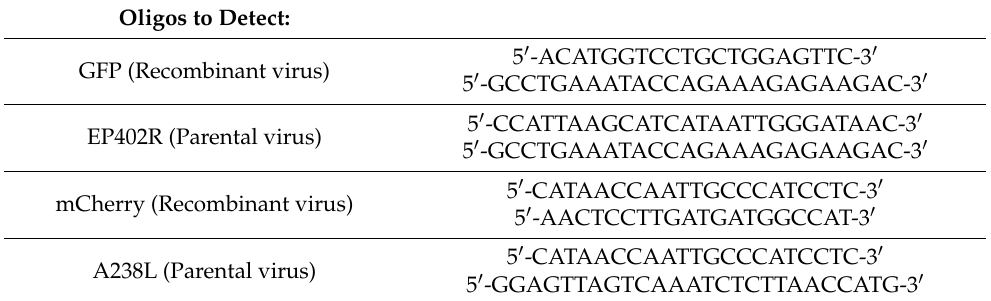
Table 1. Oligos used for the detection of recombinant and parental viruses by PCR. Oligos to Detect: GFP (Recombinant